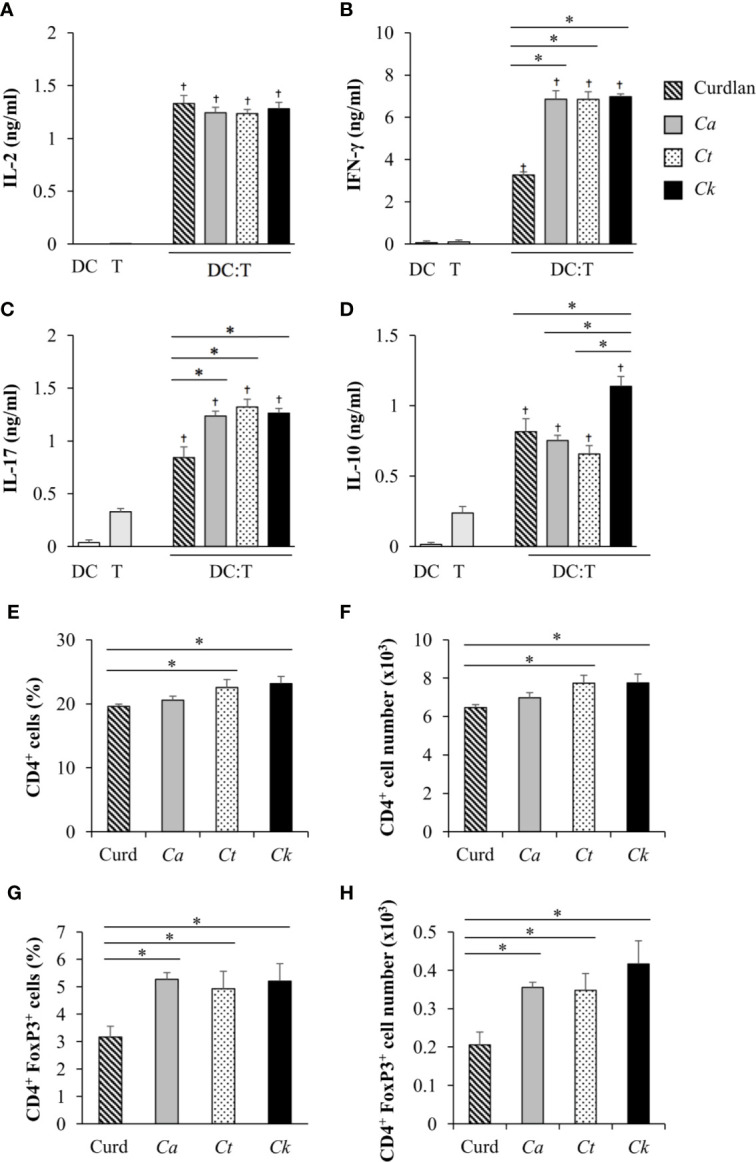
Effects of C. krusei β-glucans-stimulated bone-marrow derived dendritic cell (BMDC) on cytokine production of T cells. BMDCs were stimulated with 25 µg/ml of curdlan and β-glucans isolated from C. albicans, C. tropicalis, and C. krusei for 24 h. The stimulated BMDCs were co-cultured with murine splenic T cells at a DC:T cell ratio of 1:10 in the presence of soluble anti-mouse CD3 monoclonal antibody (30 ng/ml). Levels of T cell cytokines were assessed in culture supernatants. (A) IL-2 levels were measured following 24 h of co-culture. (B) IFN-γ, (C) IL-17, and (D) IL-10 levels were measured following 72 h of co-culture. BMDCs alone and T cells alone were incubated with the soluble anti-CD3 antibody as negative controls. n = 3; the percentages and numbers of CD4+ T cells and CD4+FoxP3+ were determined following 72 h of co-culture by flow cytometry. n = 3; (E) percent and (F) number of CD4+ cells, (G) percent, and (H) number of CD4+FoxP3+ cells. data are representative of two independent experiments. †
p<0.05 compared with negative controls, *p<0.05. DC, BMDCs; T, T cells, Ca, C. albicans; Ct, C. tropicalis; Ck, C. krusei.